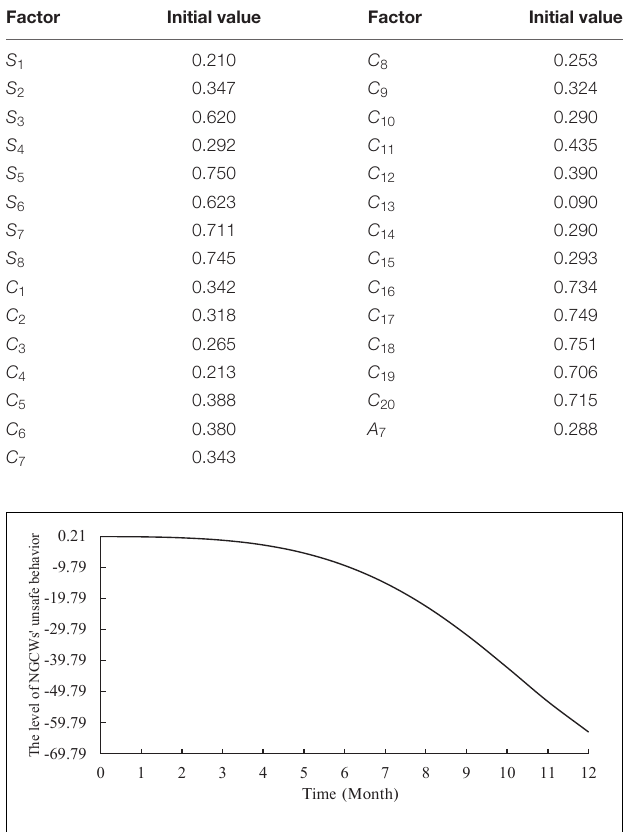
FIGURE 4 | Evolution trend of NGCWs’ unsafe